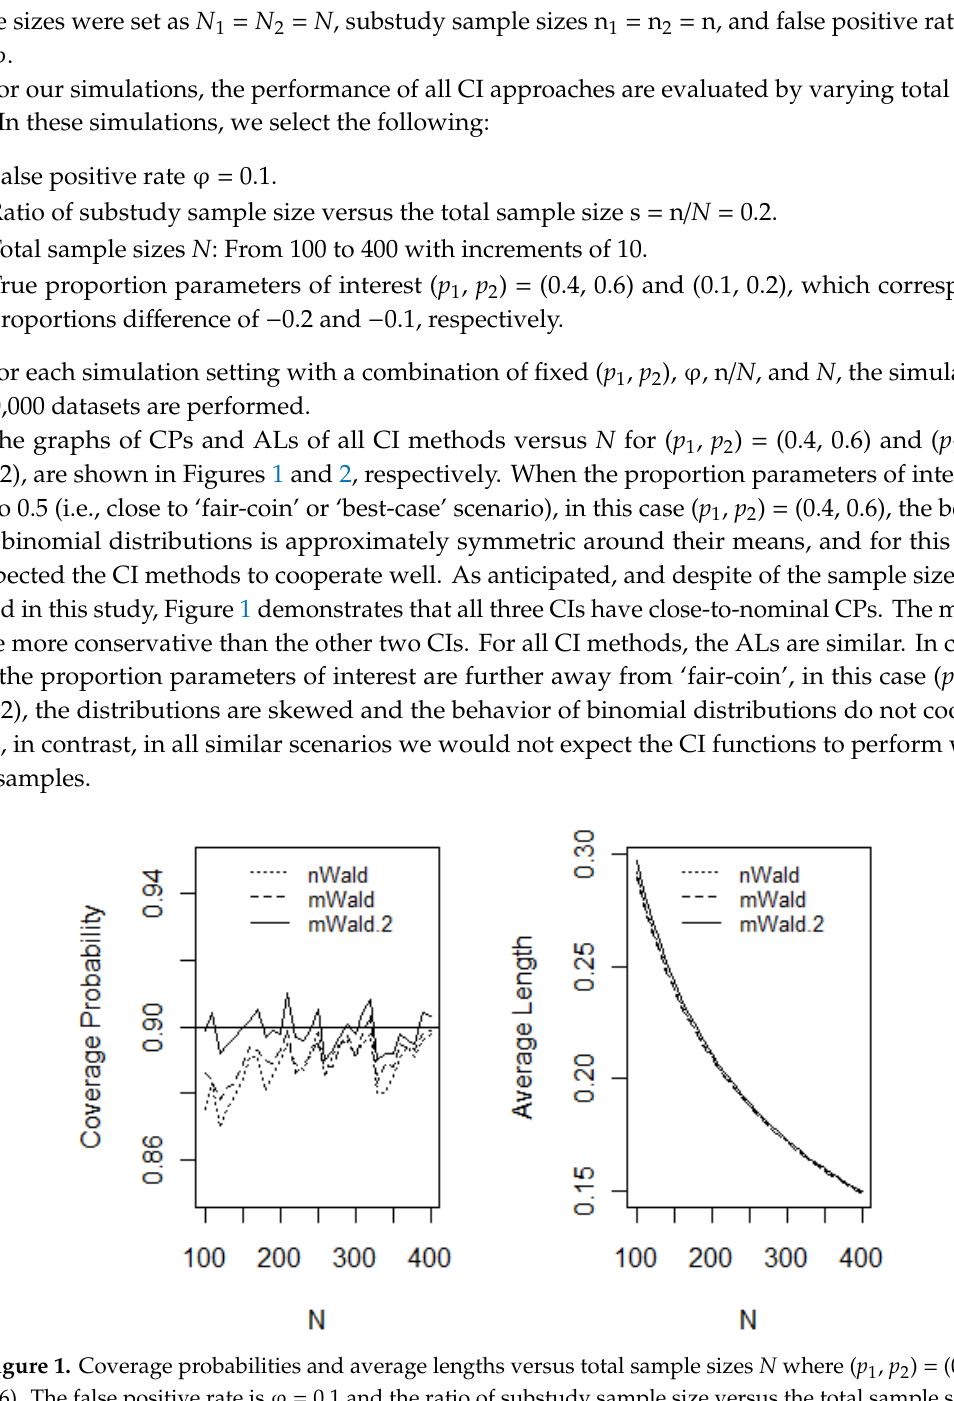
Table 4. nWald, mWald, mWald.2 90% confidence intervals (CIs) and CI lengths (between Group A